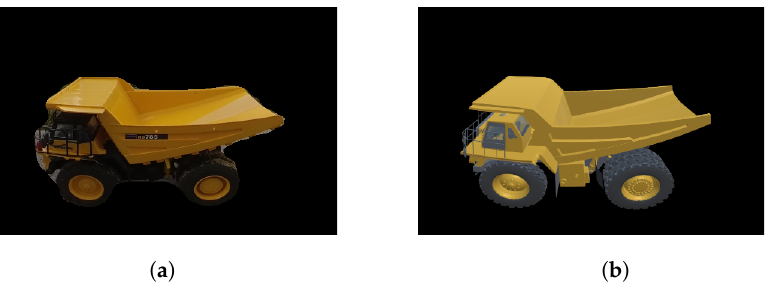
Figure 4. Real-world and synthetic images taken as example to illustrate the different terms of the cost function. ( a ) Real-world image. ( b ) Synthetic